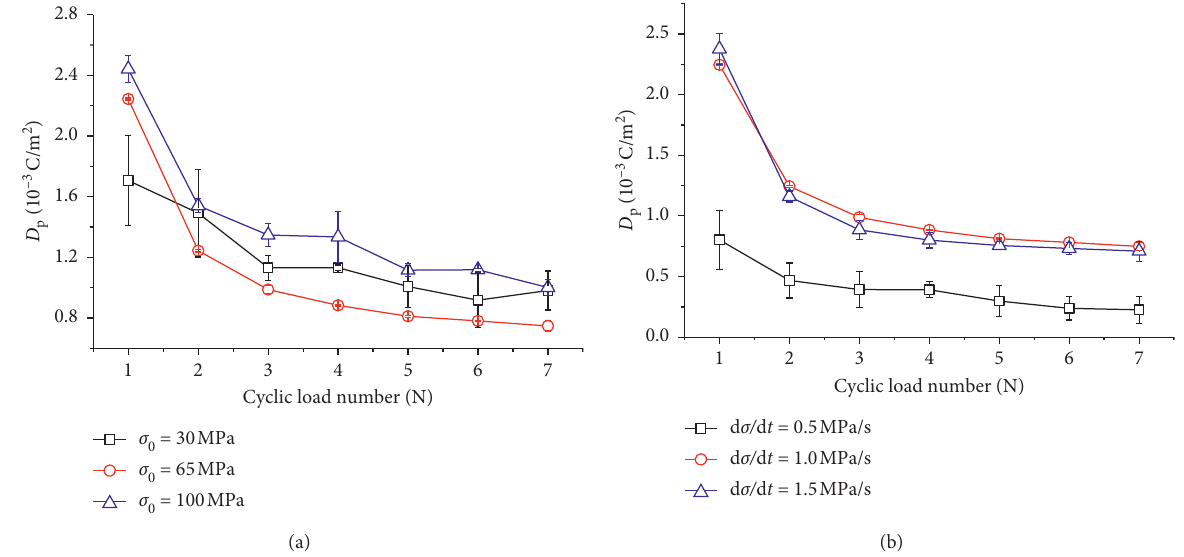
Figure 9: D p versus the case with cyclic load number at (a) d σ /d t